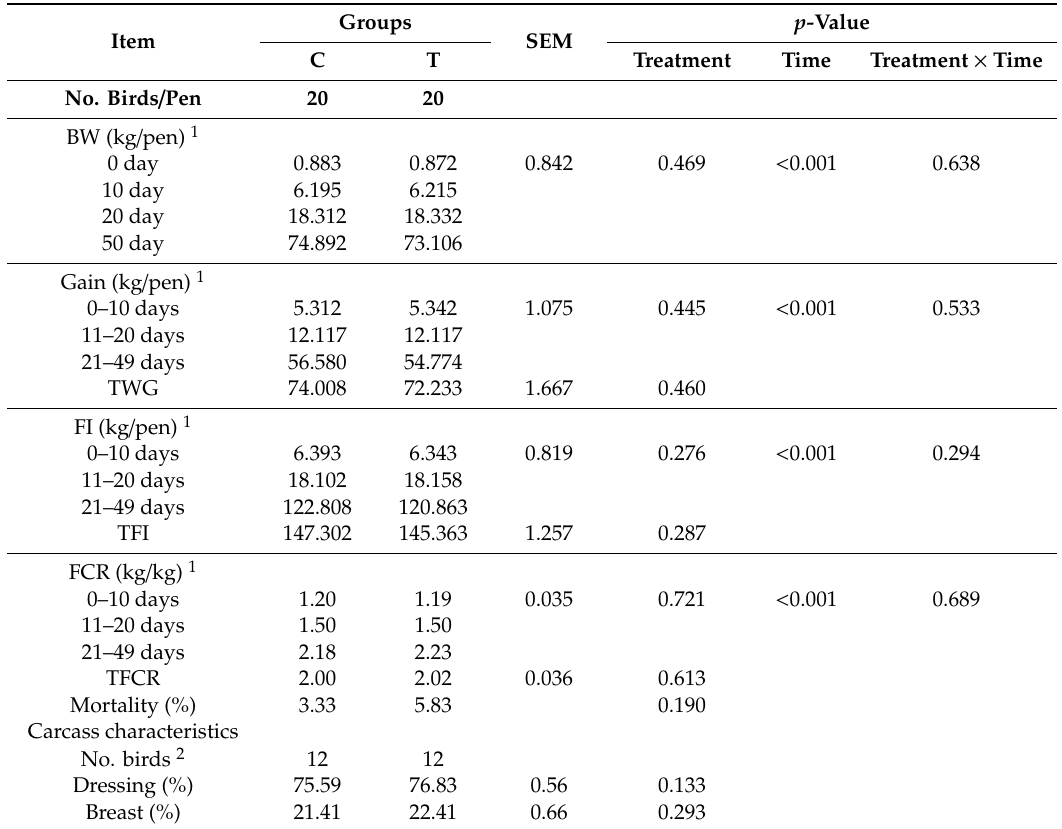
Table 2. E ff ects of plant extract supplementation on growth performance parameters and carcass characteristics of broilers. Data shown as LSMeans ± SEM. p- Value Groups Item SEM C T Time